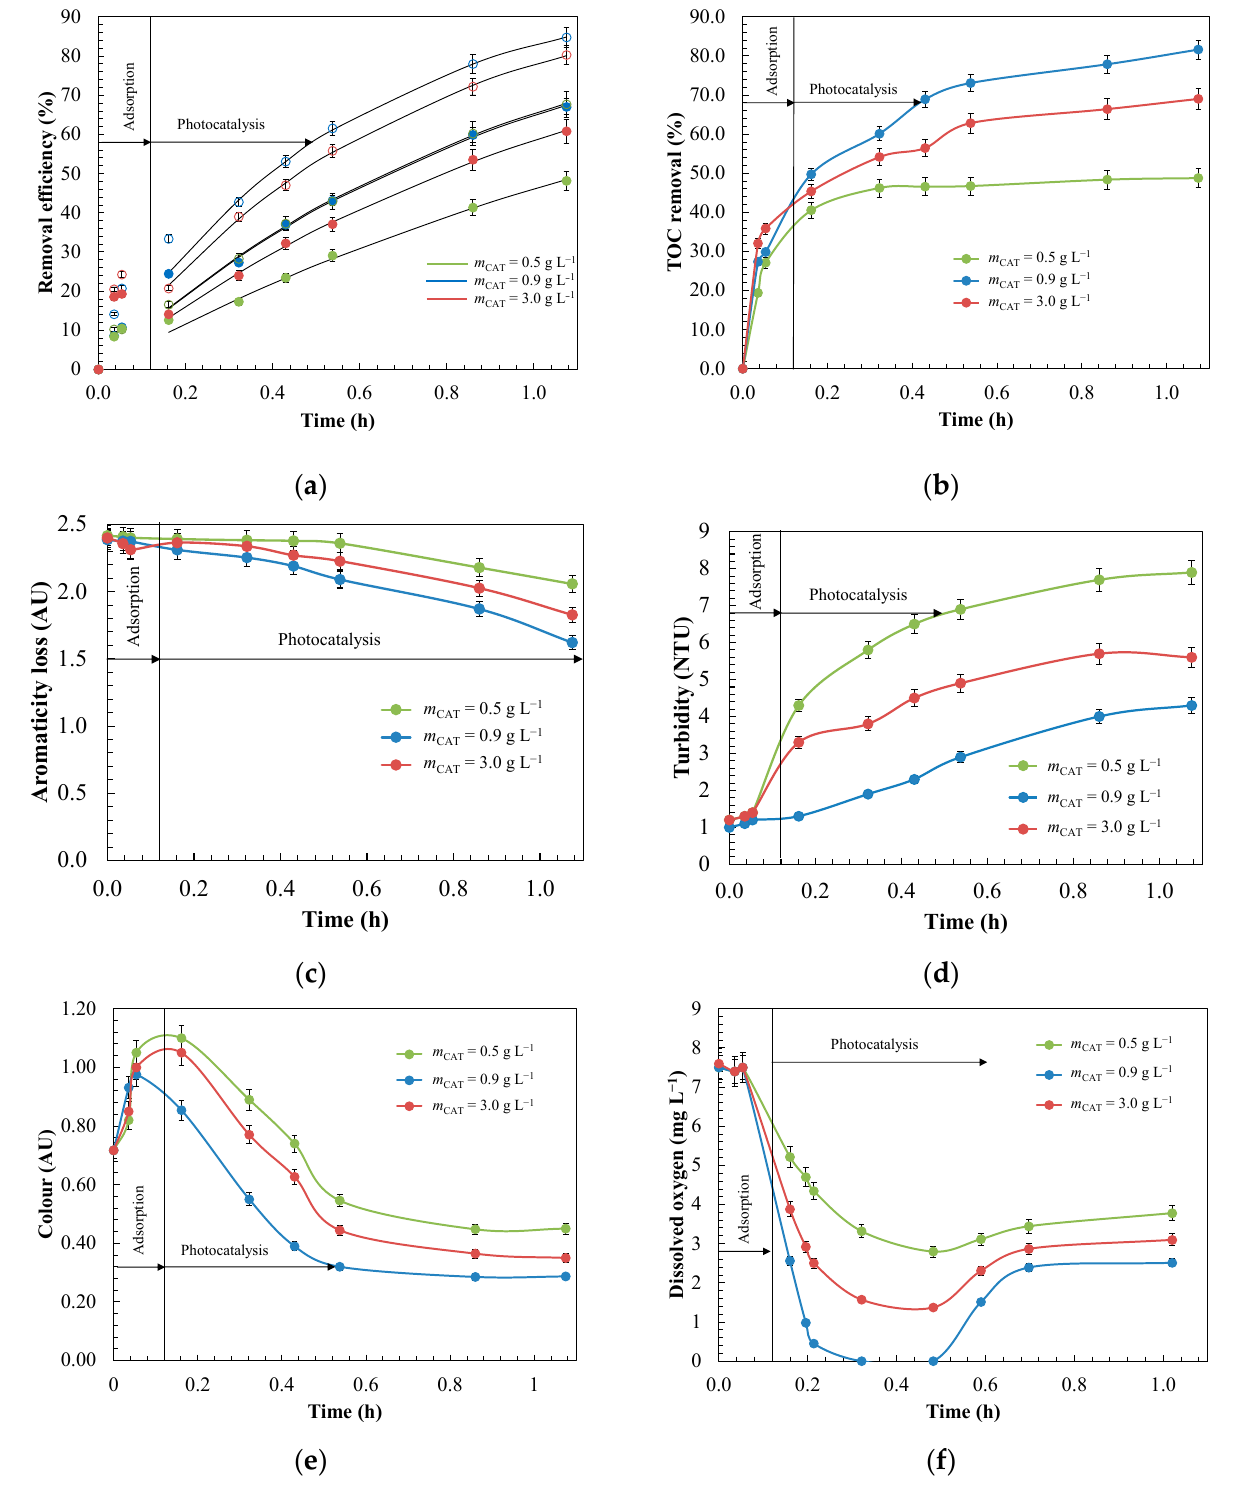
Figure 13. Plots showing the variation in the effect of the MnO 2 /GAC-3 catalyst dose during the photocatalytic removal of ANI and BTH from industrial effluents. Evolution of the: ( a ) primary degradation of ANI ( ○ ) and BTH ( ● ) fitted to the apparent first-order kinetic model; ( b ) total organic carbon (TOC) removal; ( c ) aromaticity loss; ( d ) turbidity; ( e ) colour induction during aniline and benzothiazole oxidation; ( f ) dissolved oxygen. Experimental conditions: C 0 = 12.0 mg L − 1 ; pH = 9.0; T = 26 °C.